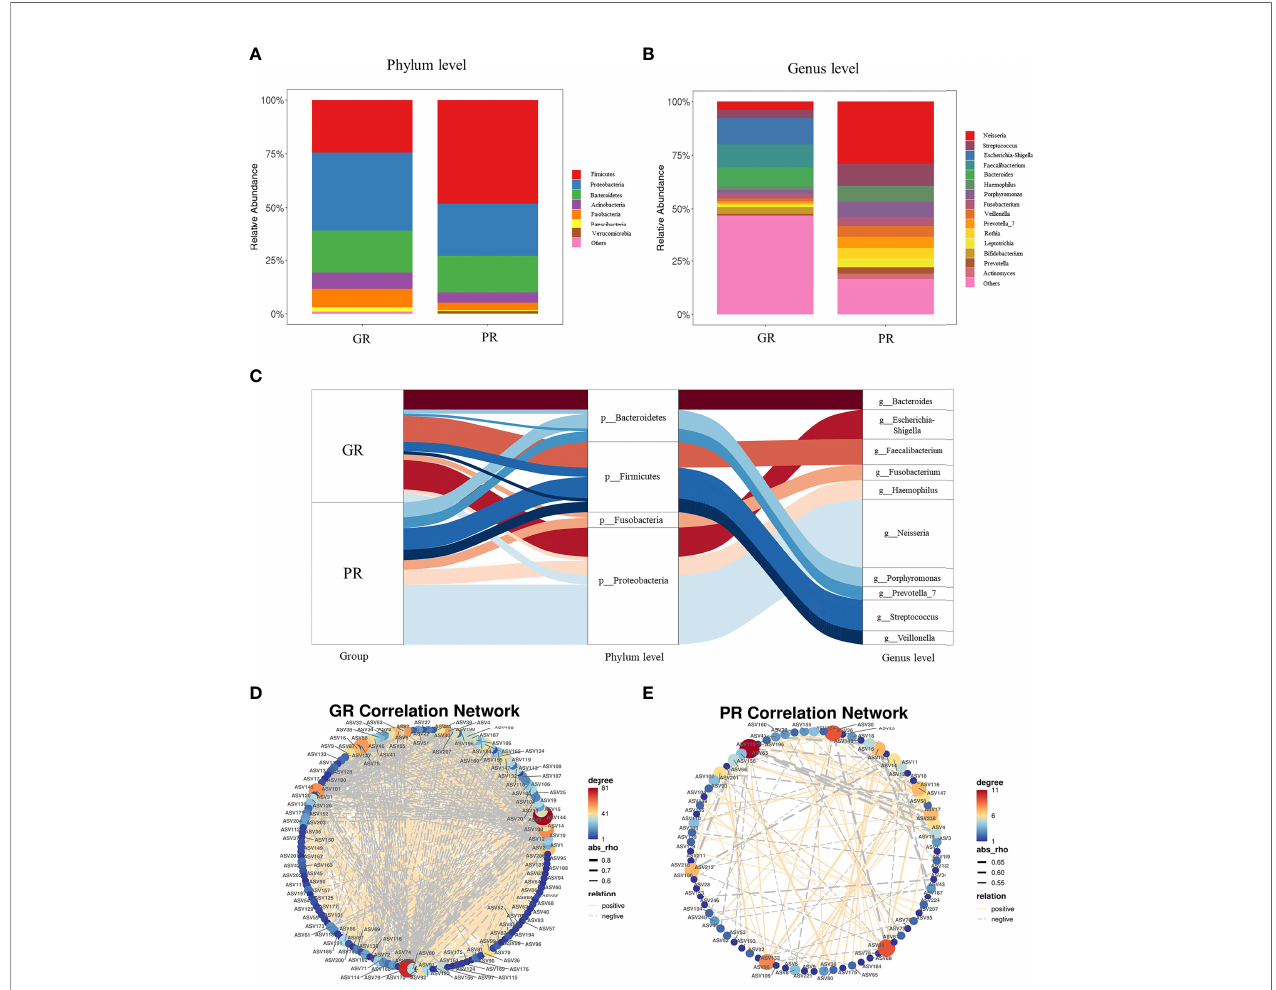
FIGURE 3 | Comparison of the relative abundances at the phylum and genus levels. (A, B) The composition of bacteria at the phylum level (A) and at the genus level (B) . (C) Sankey plot visually showed the top relative abundance of bacteria at phylum and genus levels in both the GR and PR groups. (D, E) ASVs correlation network analysis. In total, SparCC correlation coef fi cients of |rho| >0.5 and P value <0.05 were used. The edge thickness indicates the strength of the correlation. The node size and color represent the number of other bacteria associated with the bacterium. PR, poor response; GR, good